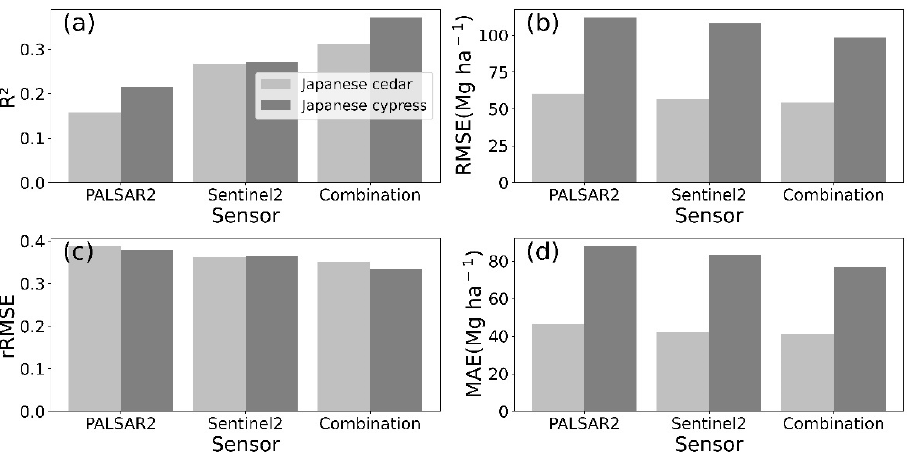
Figure 10. Comparison of the accuracy of the different models (separate models for PALSAR ‐ 2 and Sentinel2 and a model that combines both datasets): ( a ) coefficient of determination ( R 2 ), ( b ) root ‐ mean ‐ square error ( RMSE ), ( c ) relative RMSE ( rRMSE ), and ( d ) mean absolute error ( MAE ).